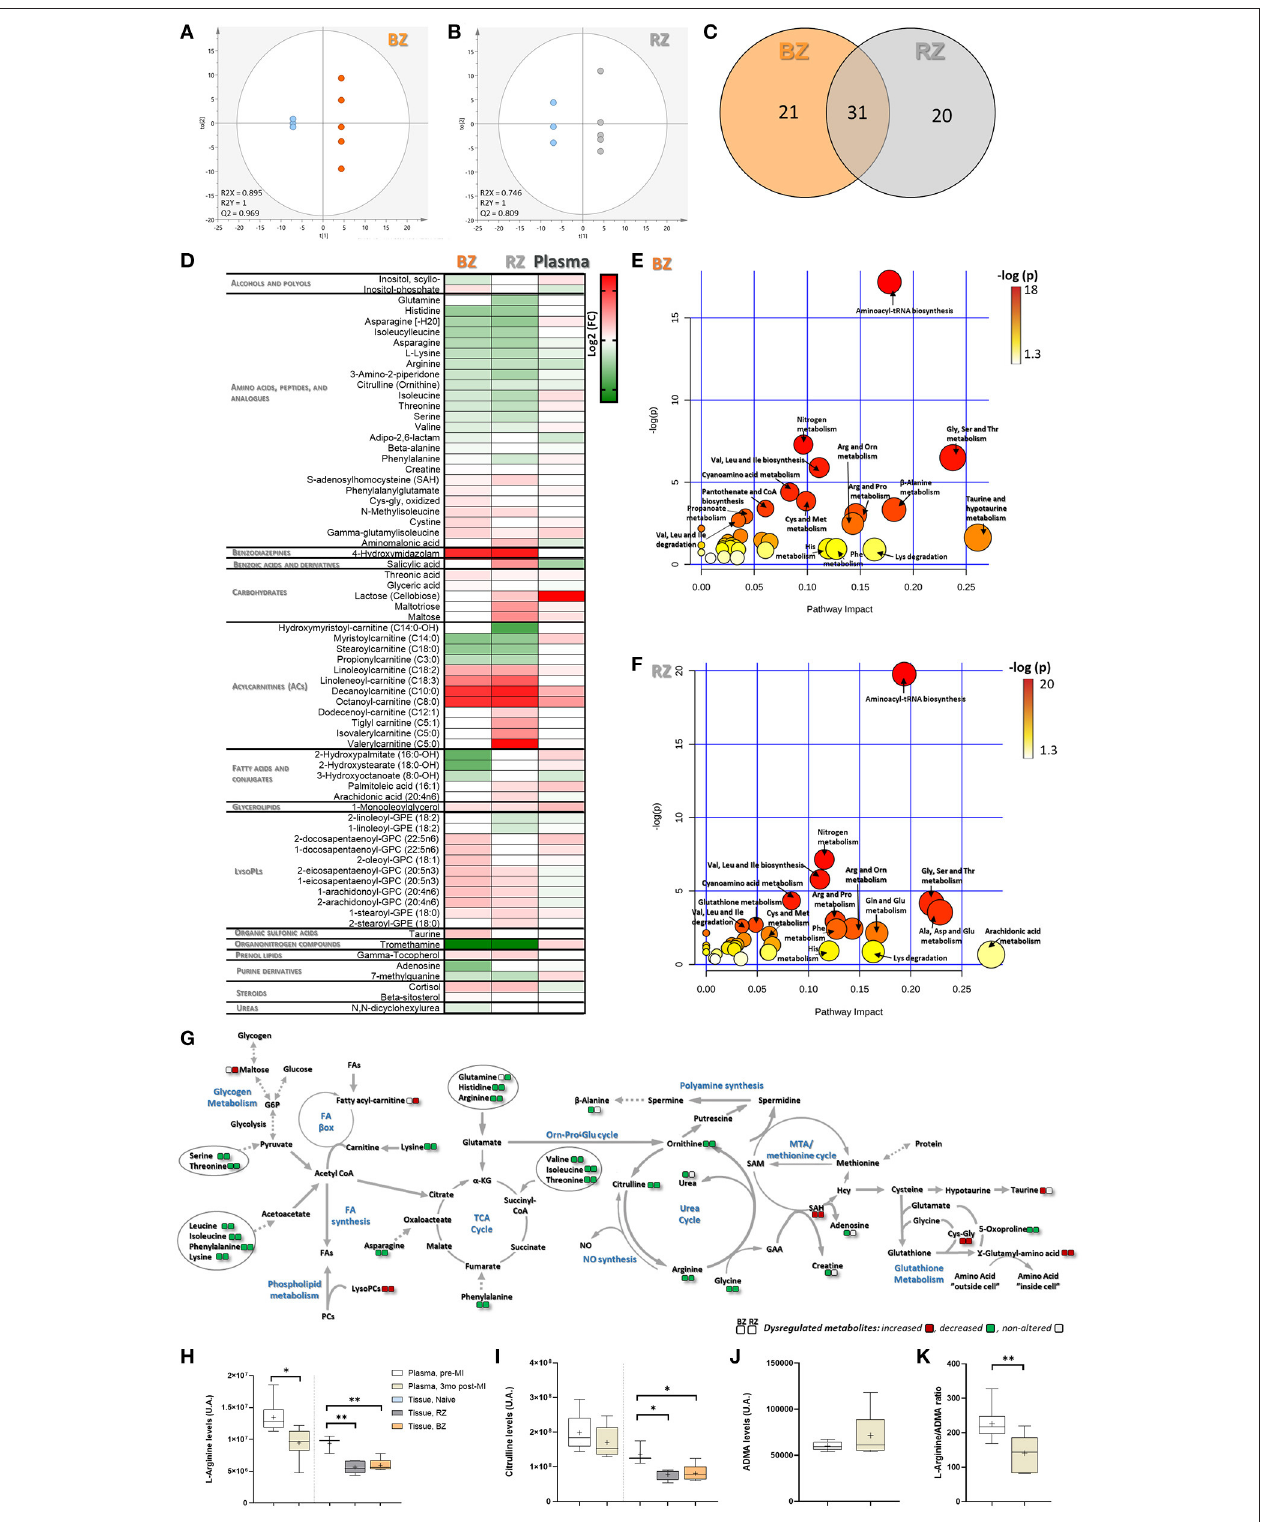
FIGURE 3 | Tissue-level metabolomic characterization of remote and border zones of infarcted pig hearts. Score plot of the OPLS-DA model for: (A) BZ (orange) and control, LV Naïve tissue (blue) and (B) RZ (gray) vs. control (blue), showing clearly separation between RZ/BZ and the control group. R2 and Q2 parameters indicate a relatively good predictive capability of the models. Metabolites with VIP values > 1.2 were considered as stronger contributors to discrimination among groups and